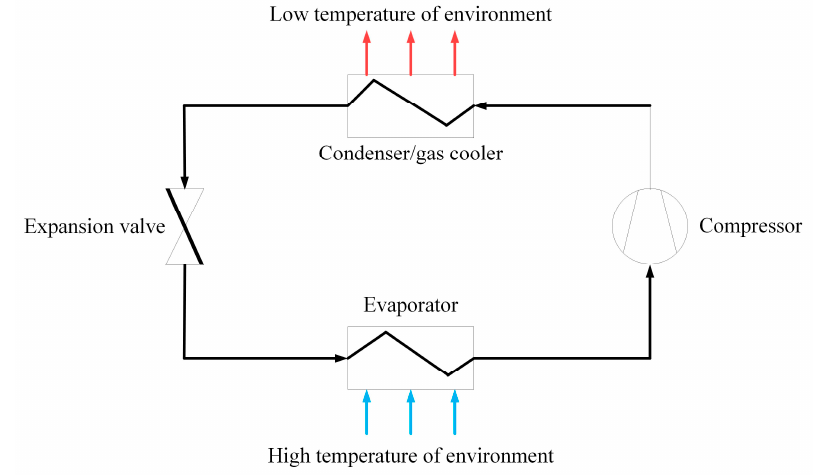
Figure 19. Scheme of the subcritical vapor compression heating working cycle.